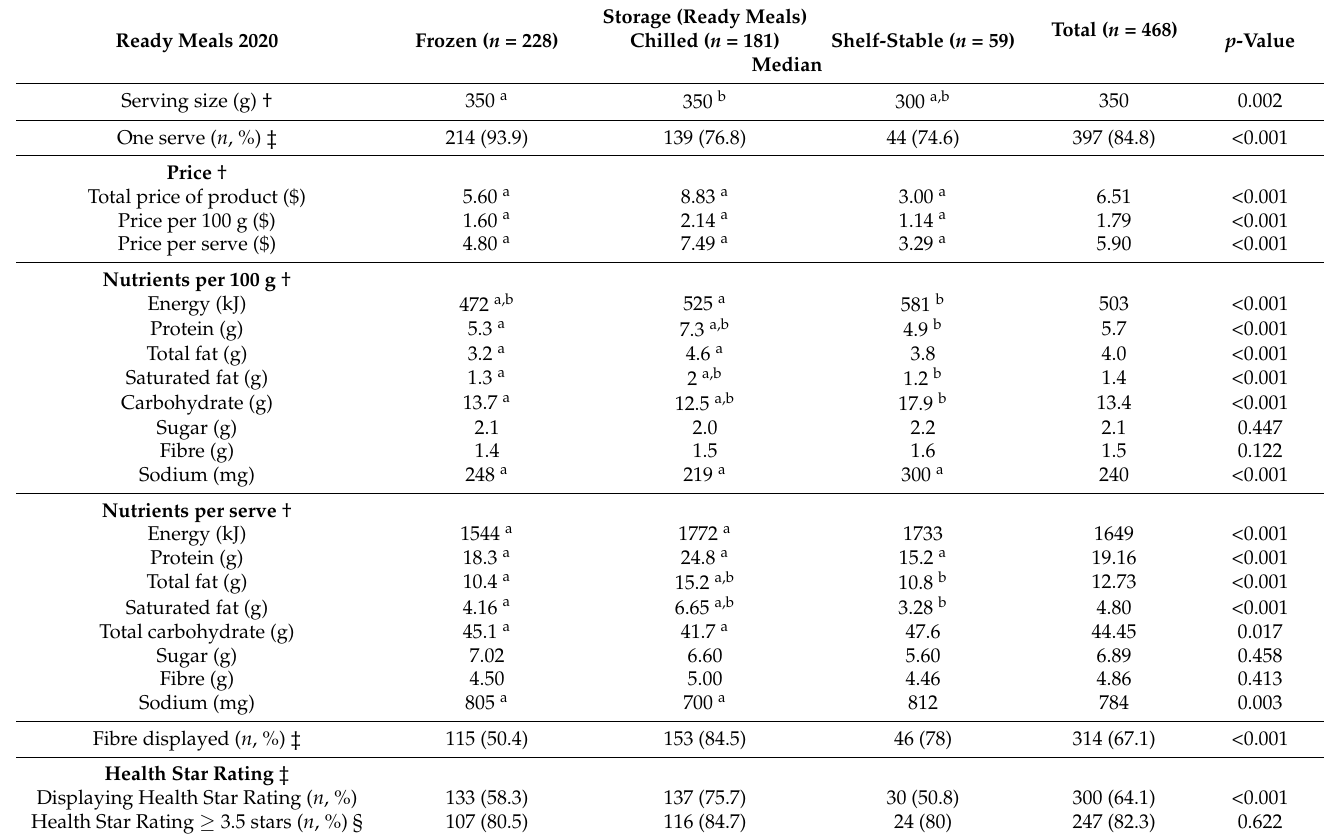
Table 2. Serving size, number of serves, price, nutrient content and Health Star Rating of ready meals by storage classification in 2020 (median, count and